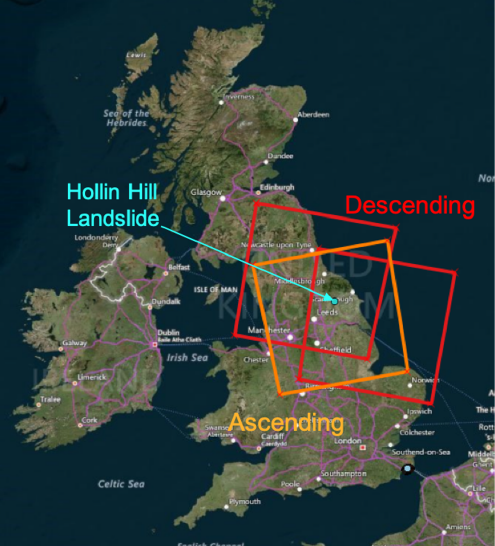
Figure 1. Location of the Hollin Hill Landslide Observatory and the Sentinel-1 InSAR frames that cover this